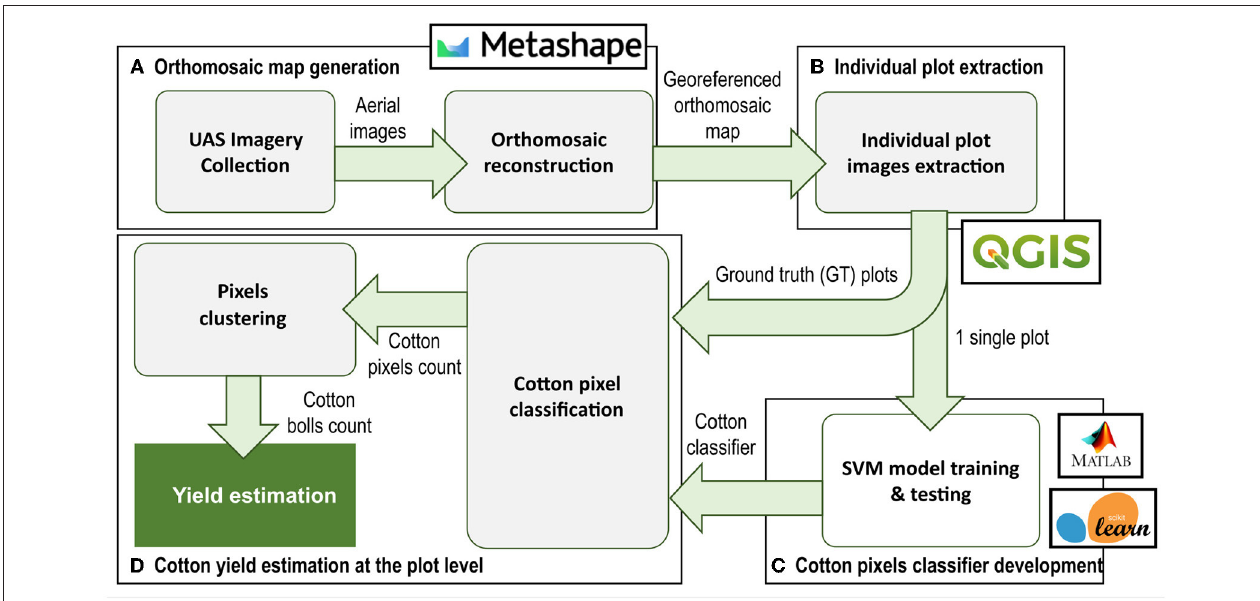
FIGURE 4 | Data processing pipeline. The process pipeline includes 4 main steps: (A) Orthomosaic map generation, (B) Individual plot extraction, (C) Image pixel classifier development, and (D) Cotton yield estimation at plot level. Green arrows indicate the flow of data/information between processes.